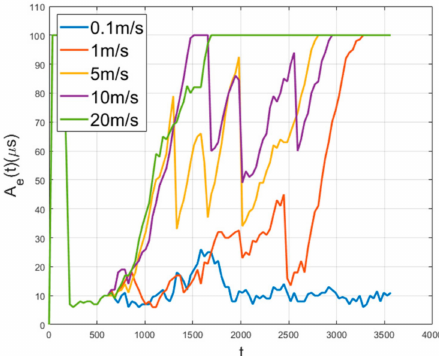
Figure 11. Network error with no boundary.